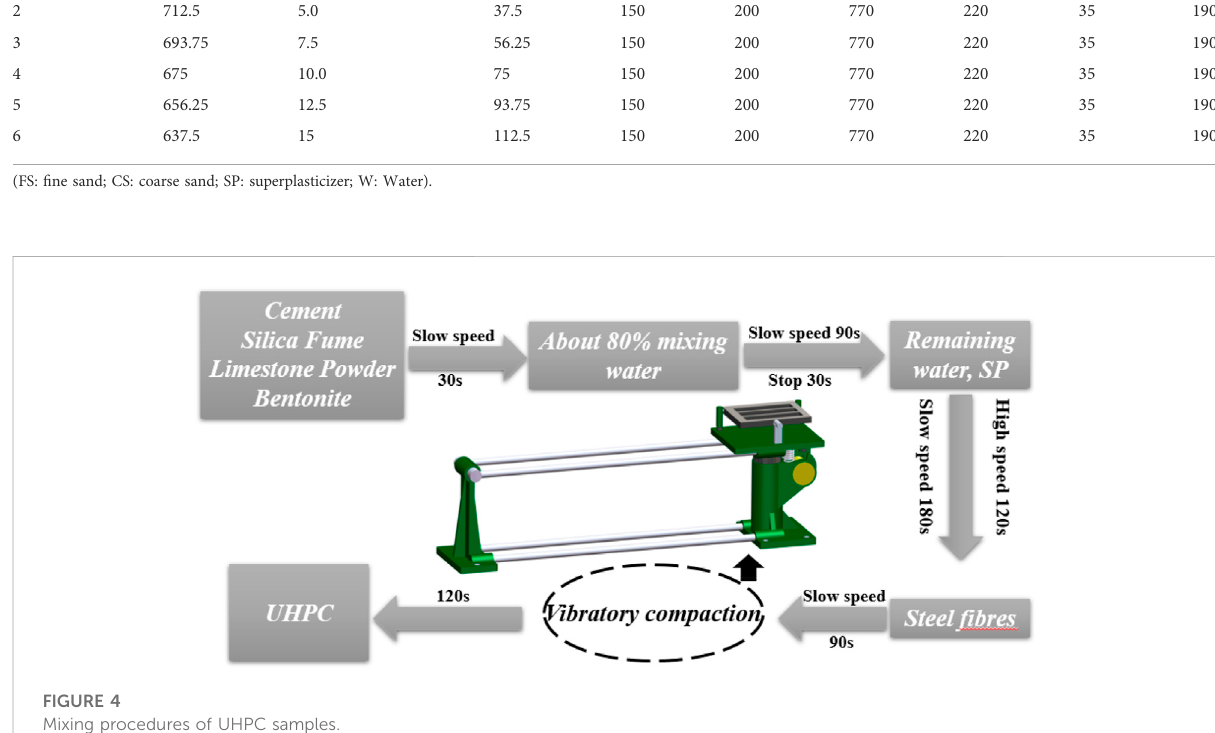
Figure 5. First, the fresh UHPC slurry was measured for 30 s at a constant shear rate of 25 s − 1 . Next, the slurry should be rested for 60 s. At last, the fresh UHPC slurry was tested under a different shear rate growth and decline protocol for 60 s, and this rate was changed from 0 to 25 s − 1 to 0.